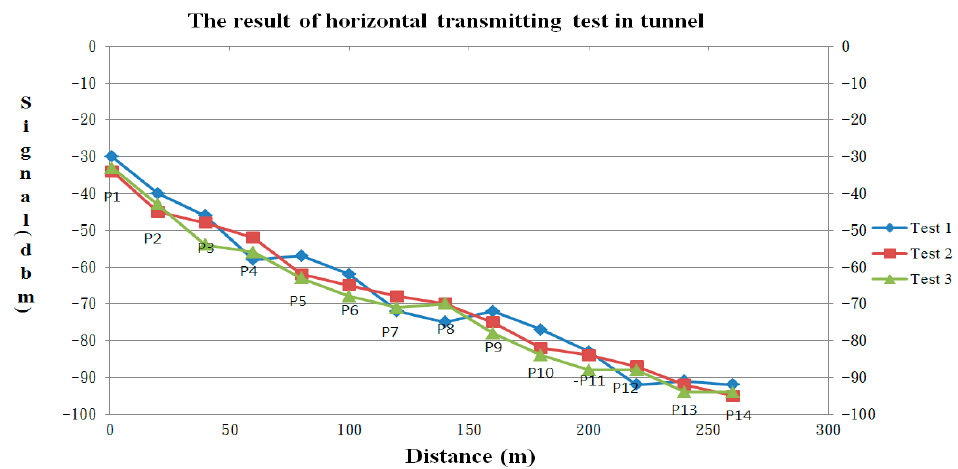
Figure 18 . The WSN performance curve in the tunnel test.